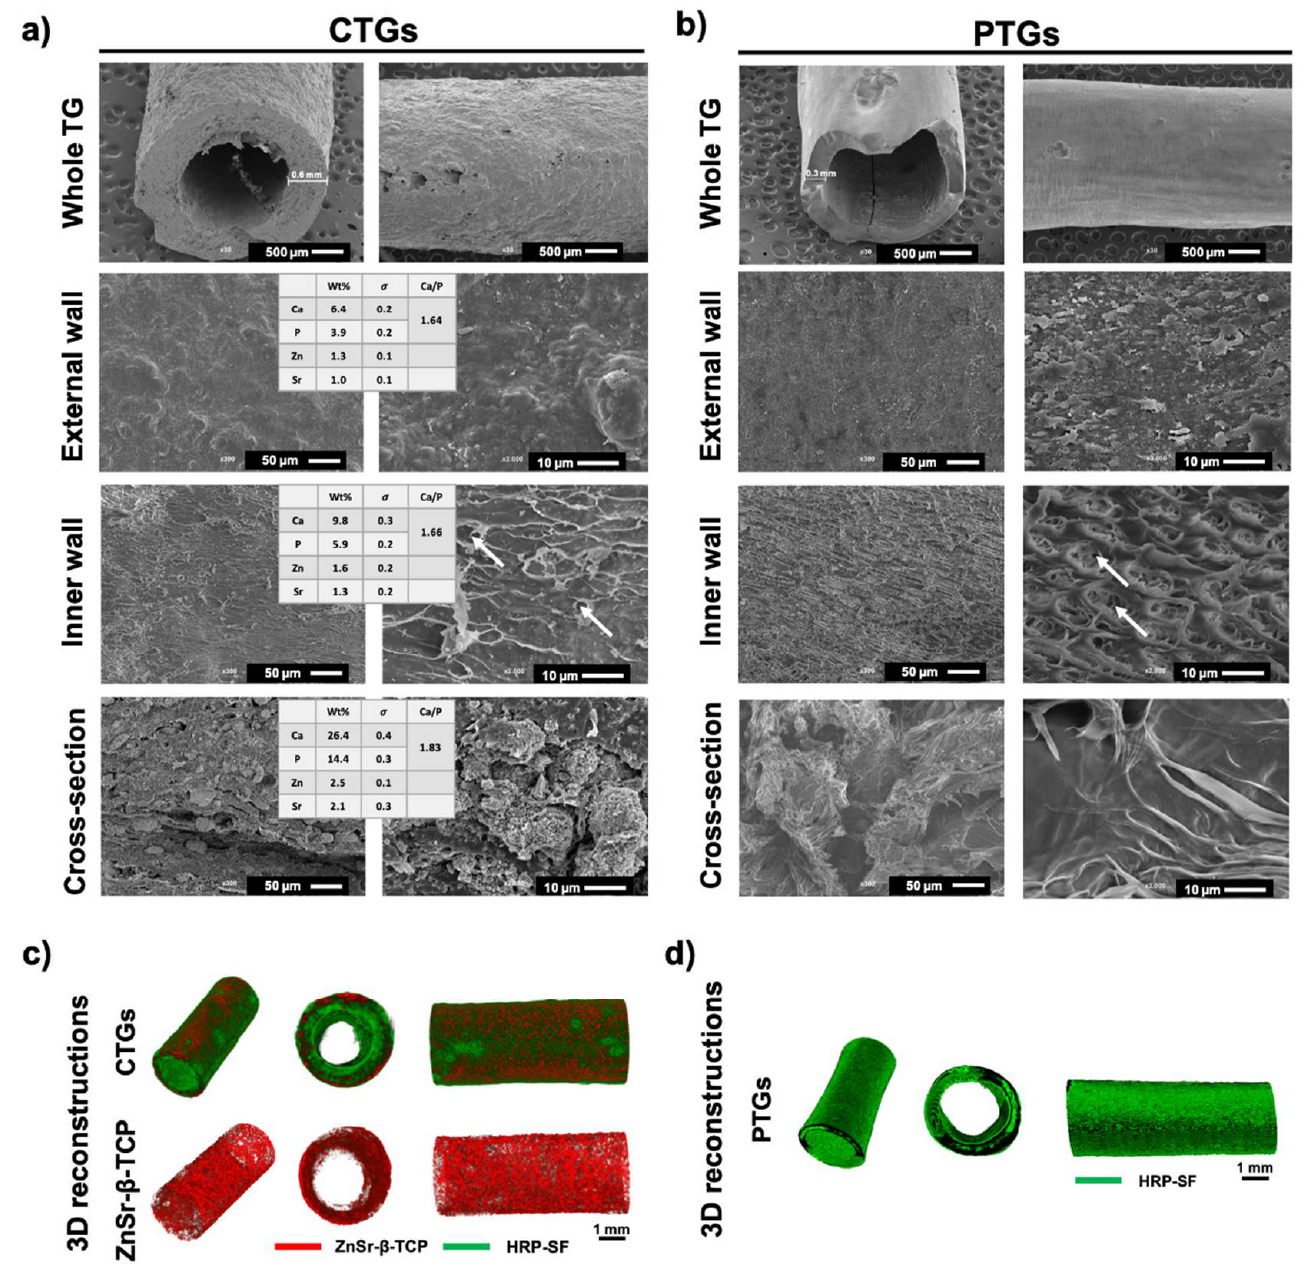
Figure 2. Macro/microstructure of the developed TGs. Representative SEM micrographs of the ( a ) CTGs and ( b ) PTGs, and EDS elemental analysis with the detected ion elements (Zn and Sr) and Ca/P ratios determined in the different regions of the CTGs (external, inner and cross-section regions). The white arrows indicate micropores (<10 µ m). Wt% stands for percentage by weight and σ stands for standard deviation. Micro-CT reconstructions of the ( c ) CTGs and ( d ) PTGs, exhibiting the ZnSr- β -TCP component distribution in the TGs (in red) and the HRP-SF hydrogel matrix (in green).